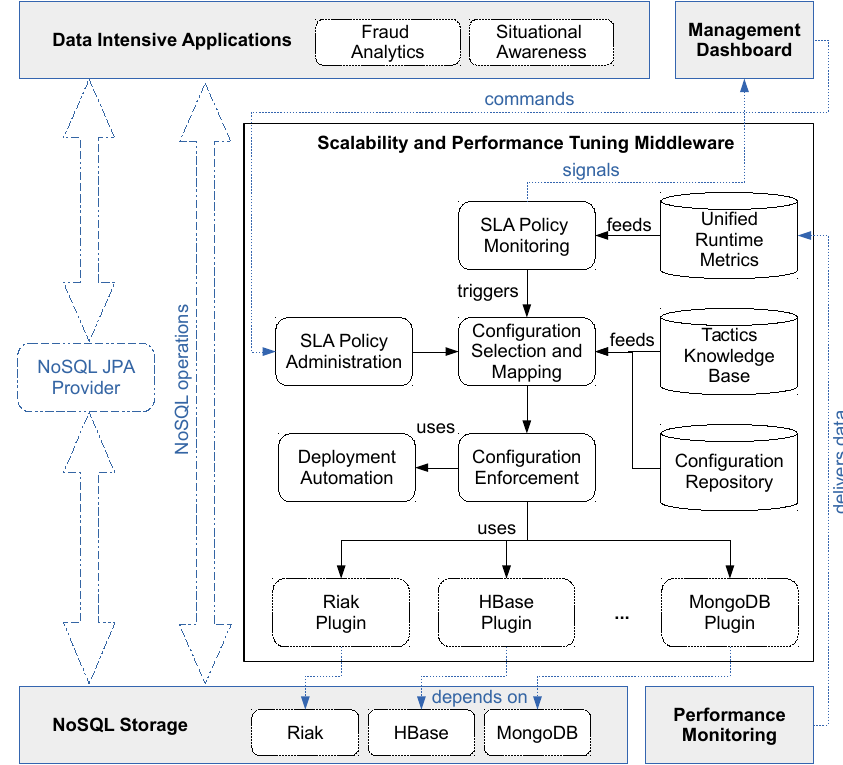
Figure 6. PaSTA: middleware to tune performance and